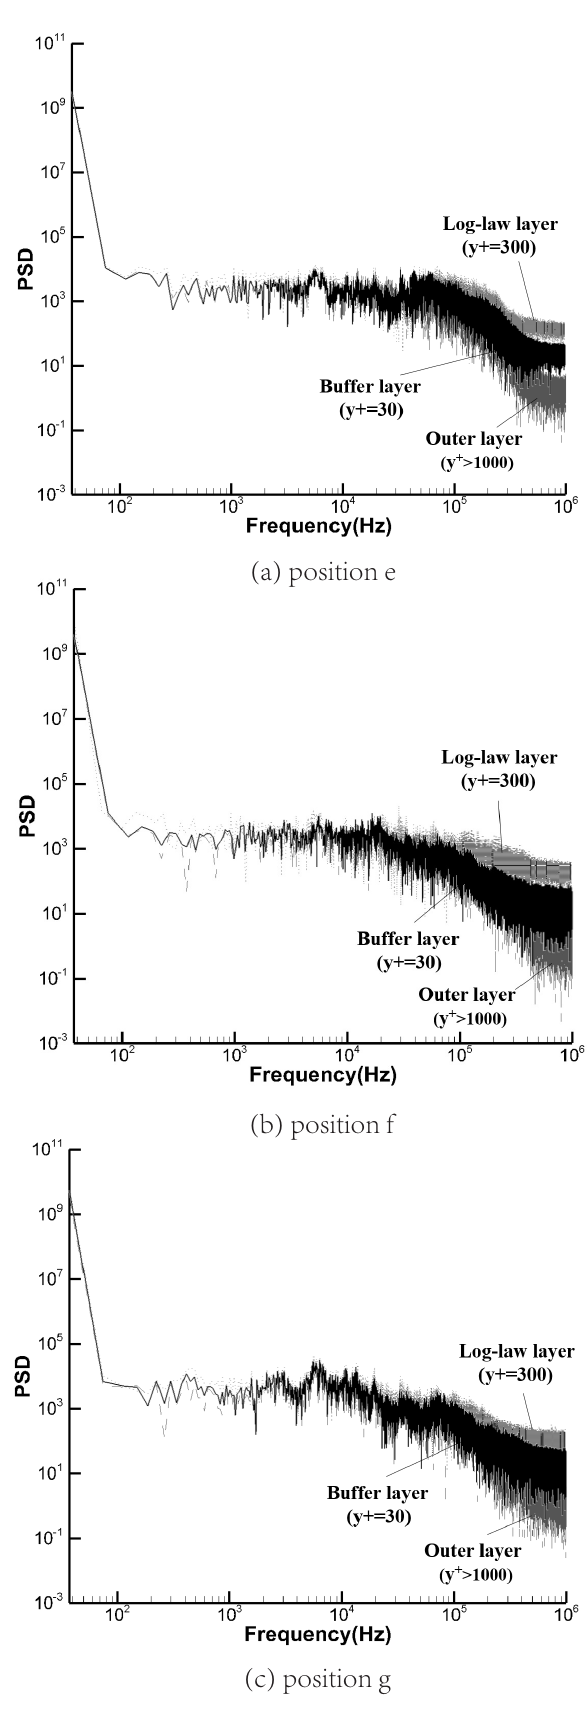
Figure 10. PSD at positions